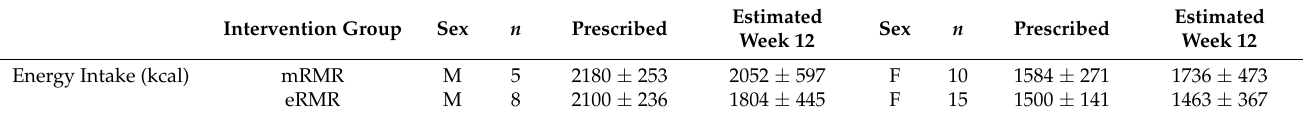
Table 7. Prescribed energy intake versus estimated energy intake at week 12 for male and female